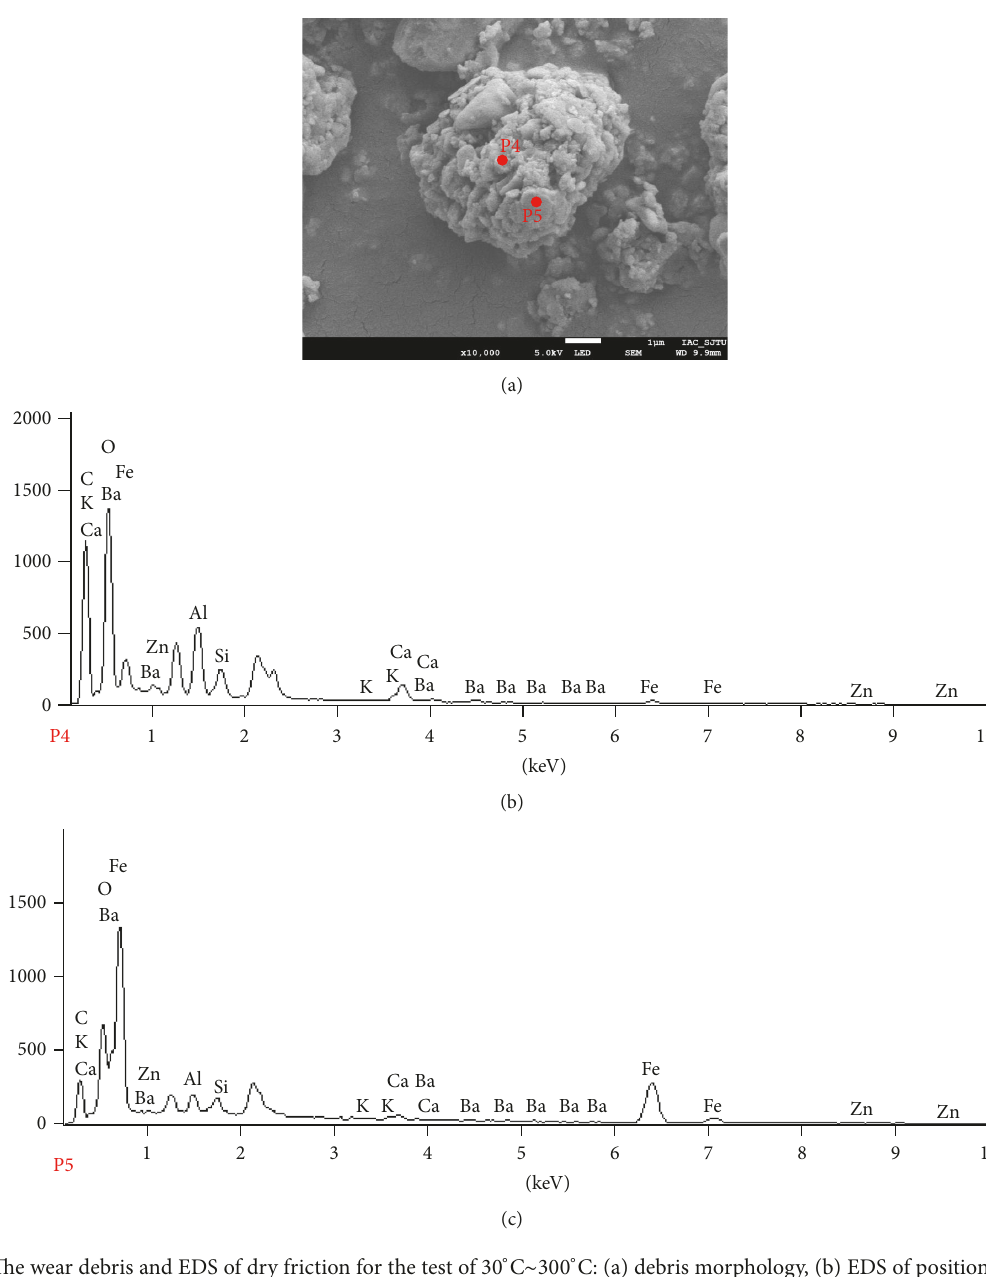
Figure 11: The wear debris and EDS of dry friction for the test of 30 ∘ C ∼ 300 ∘ C: (a) debris morphology, (b) EDS of position P4, and (c) EDS of position